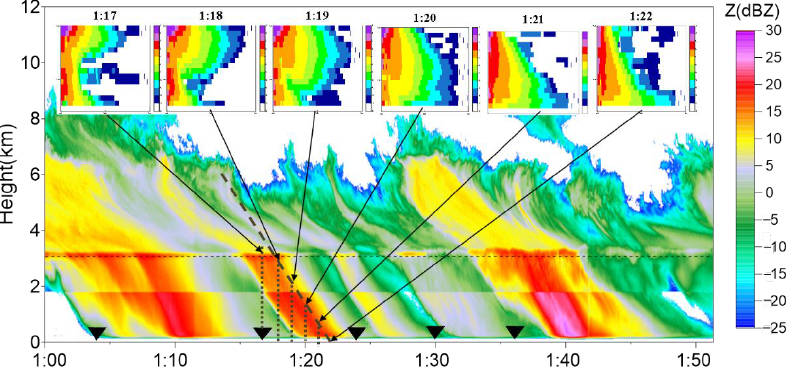
Figure 7. Detailed time – height cross sections of Z detected by CR from 1:00 to 1:50, vertical evolution of DSD from 1:36 to 1:41 are drawn in the blank area. In the convections with intermittent enhancement 1:00 – 3:03 on 16 June in Figure 6, larger V r also spread together with the strong Z along the warm layer, indicating quick falling and collision. The tilted convection structure marked with grey dotted lines devel- oped stronger and higher and the cloud tops were higher. Most BP corresponded to a transient enhancement of cloud echo, quick falling and collision, as well as the develop- ment of higher clouds. Higher cloud top can lead to lower cloud top temperature, generating more ice par- ticles. Ice particles formed near cloud top intermittently and then fell through the under- lying cloud, causing the gustiness and instability of particle aggregation. Thus, a larger number of big particles could combine, which was reflected in the BP in the rain of the warm layer below the 0 °C layer. This resulted in quick collisions and falling of particles, which enhanced stratiform precipitation, generated the rain shafts among the stratocu- mulus rain process. Tamir et al. [20] verified the important role that large particle played in initiating precipitation via rapid collision and accelerated particle growth in different types of clouds and precipitations. The appearance of large particles, including these in the ‘bulge’, is considered the start of rapid collisions and the mechanism of rain shafts. Therefore, there maybe two processes in the cloud: a continuous rainfall with drops up to around 1 mm and an intermittent process that yielded larger drops that fell through the continuous rain. 3.3. Stratiform Rain on 18 – 19 August 2021 From 18 August 2021, at 1800 UTC to 19 August 2021, at 0930 UTC, a long-lasting stratiform rain with strong R and Z > 35 dBZ was observed, as shown in Figure 8. The D m values were from 0.9 mm below the 0 °C layer to 2 mm near the ground. In the latter half of the precipitation and after a short pause at approximately 5:00 on August 19, the rain was heavier with more large particles. The temperature profile from the MWR showed that the heights of the 0 °C layer were between 3.1 and 3.3 km, as is shown in Figure 9a. The horizontal wind profiles within the entire layer, is shown in Figure 9b.